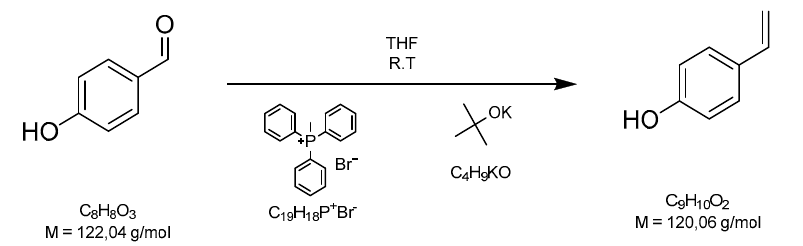
Table 1. Primers used in this